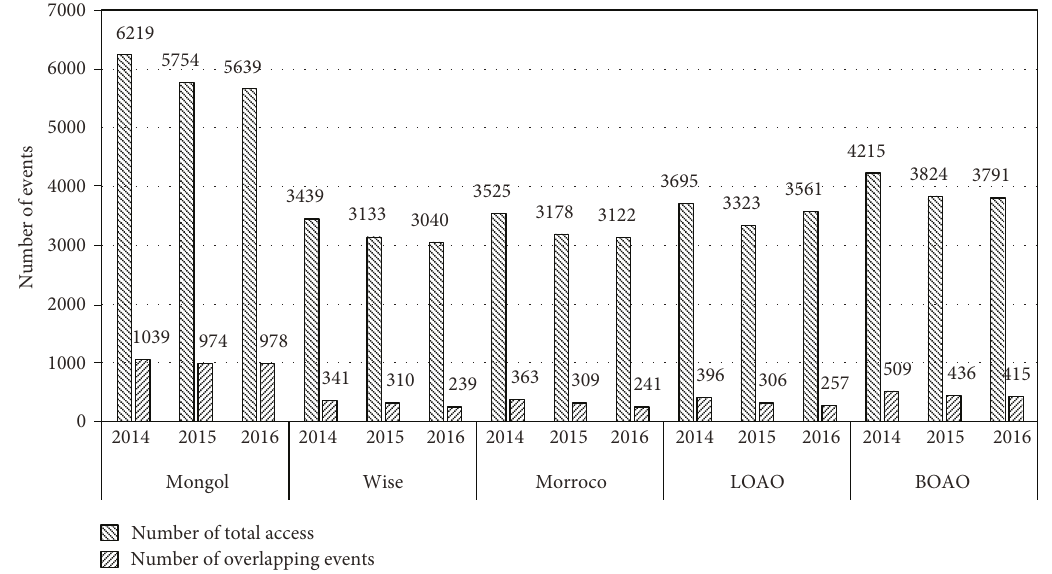
Figure 3: Number of total accesses and overlapped events for the 11 LEO observation targets at the OWL-Net from 2014 to